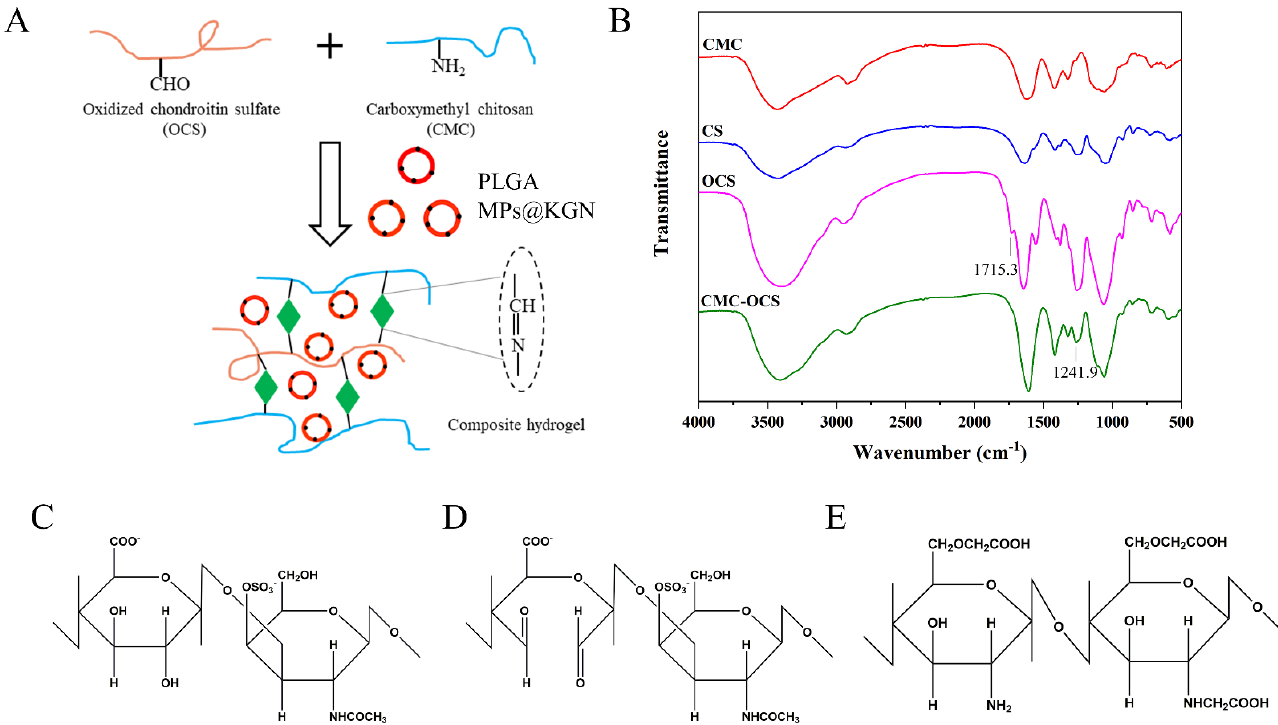
Figure 2. ( A ) Schematic illustration of the cross-linked reaction. ( B ) FTIR spectra of polysaccharide derivatives and cross-linked hydrogels. ( C – E ) Chemical structures of CS, OCS, and CMC.